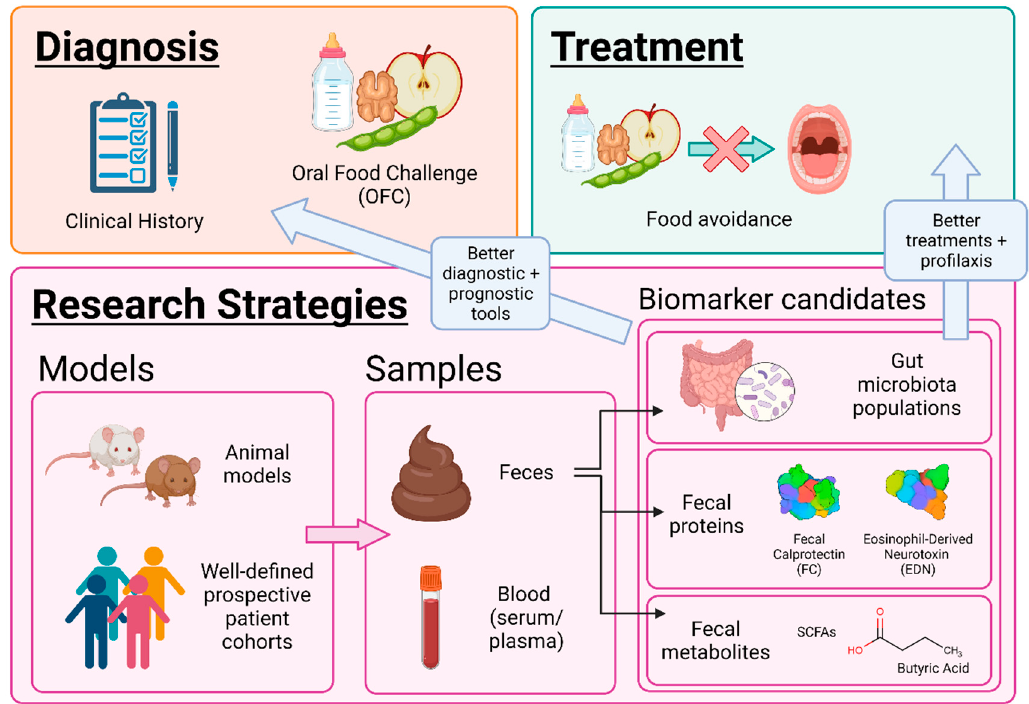
Figure 2. Approaches for the study of non-IgE-mediated gastrointestinal food allergy. SCFAs: short-chain fatty acids.